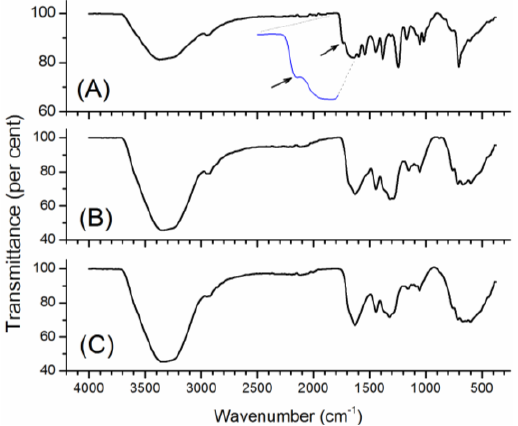
Figure 5. IR spectra of films produced under conditions of varying pH and dopant anion. ( A ) Benzoate. Inset shows the region from 1850 to 1620 cm −1 , and arrow points to feature in the benzoate-doped electrode spectrum at ca. 1736 cm −1 , assigned to a carbonyl stretch mode; ( B ) Nitrate, pH 3; ( C ) Nitrate, pH 9.